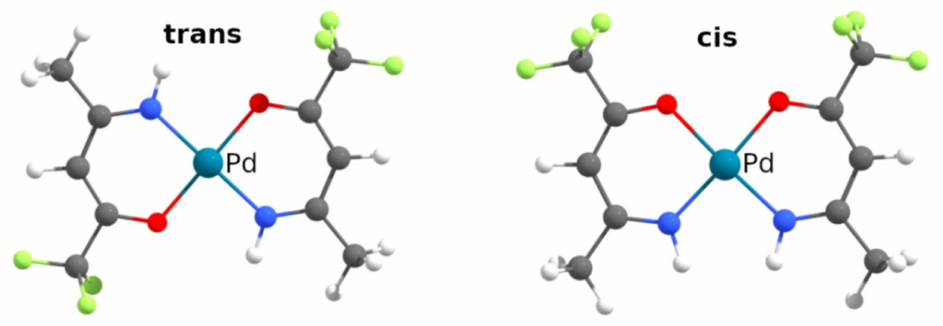
Figure 1. Two isomers of 2 : trans and cis